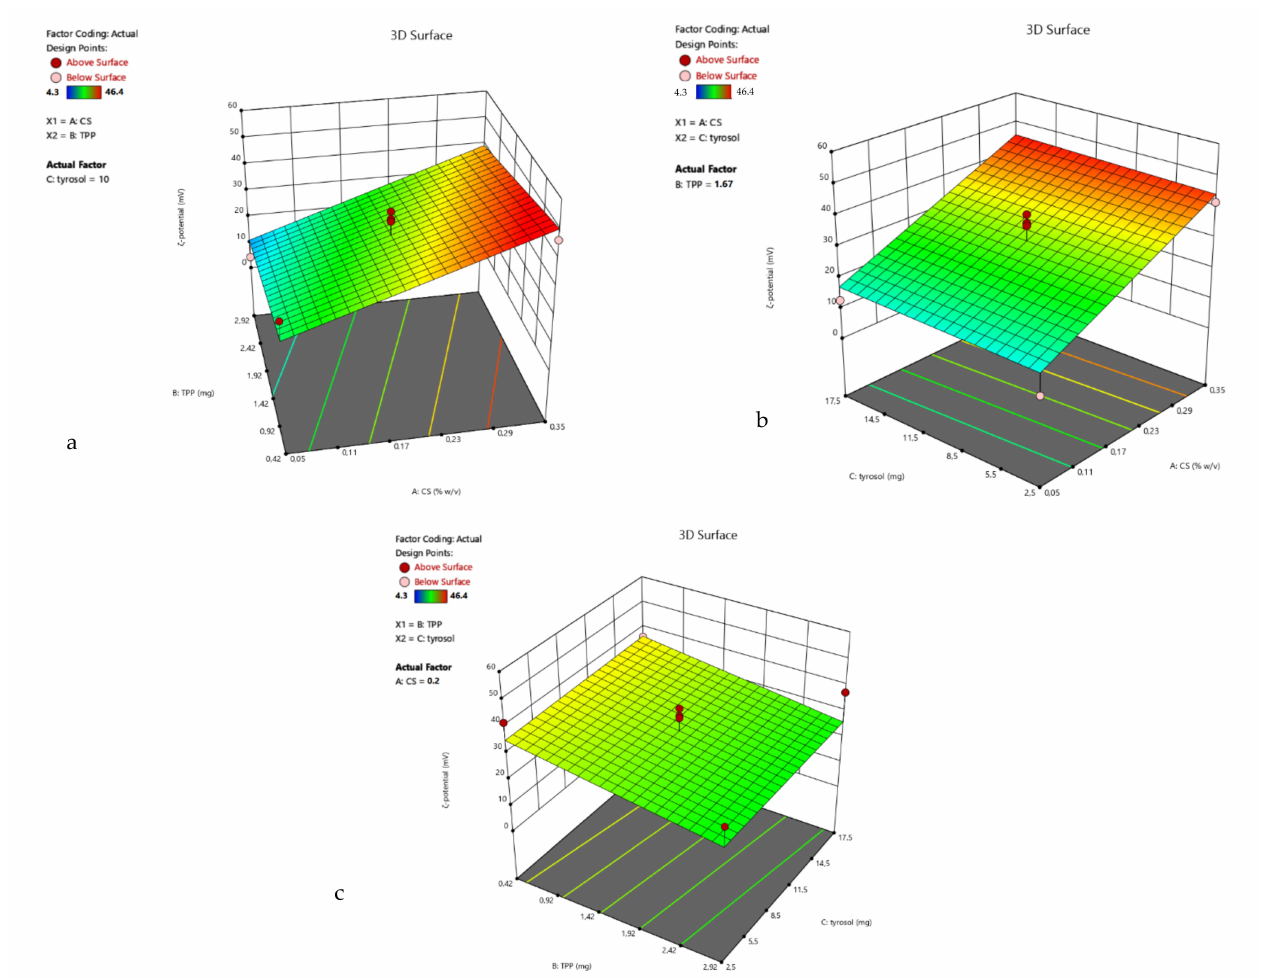
Figure 3. 3D surface plot of response R 2 of TYR/CS system ( a ) CS Vs TPP (tyrosol: 10 mg) ( b ) CS Vs TYR (TPP: 1.67 mg) ( c ) TPP Vs TYR (CS: